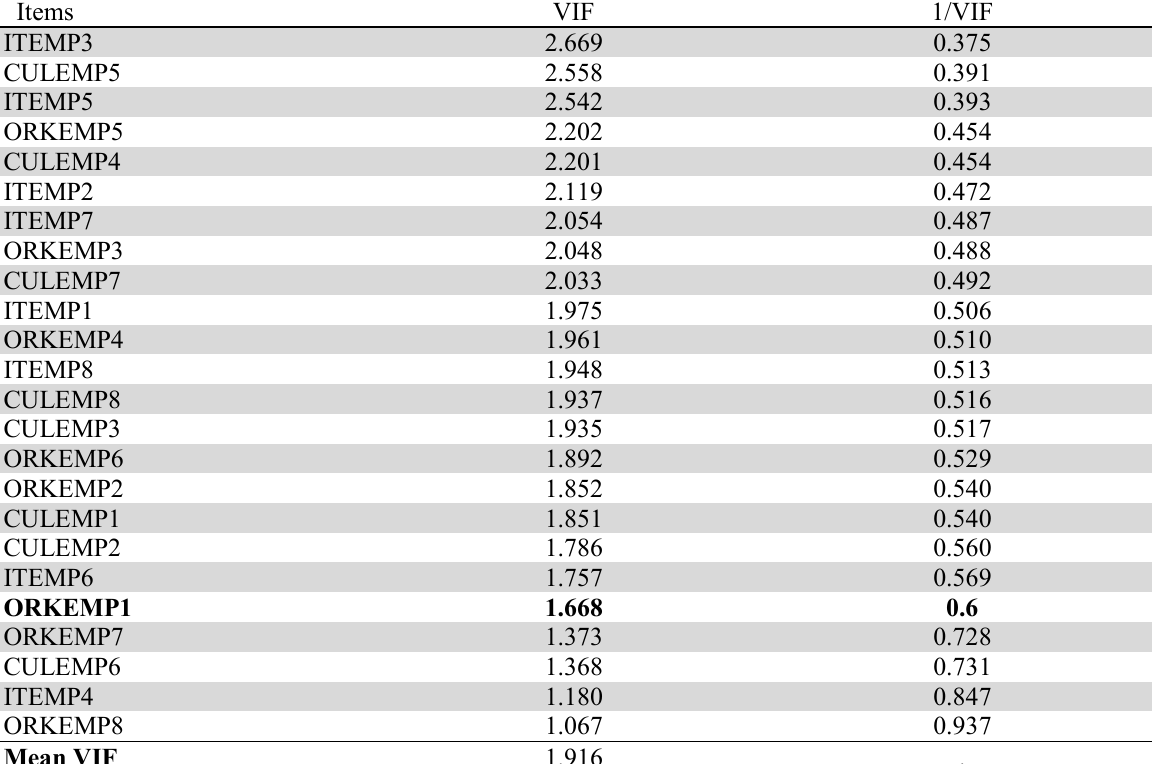
VIF and Tolerance level for selected items of exogenous variable (Human Development )